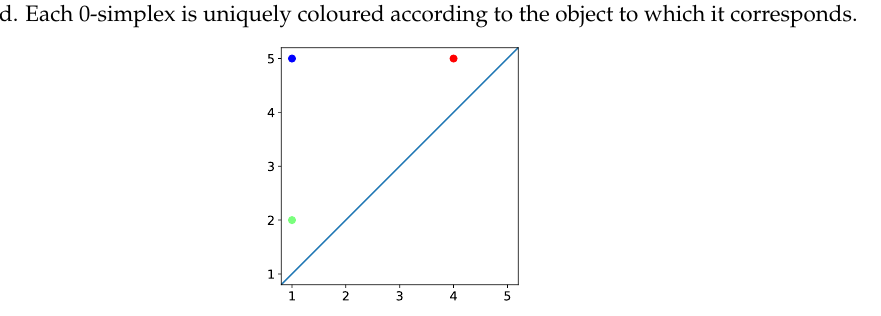
Figure 7. The persistence diagram corresponding to the tracking of Figure 6 is displayed and contains three